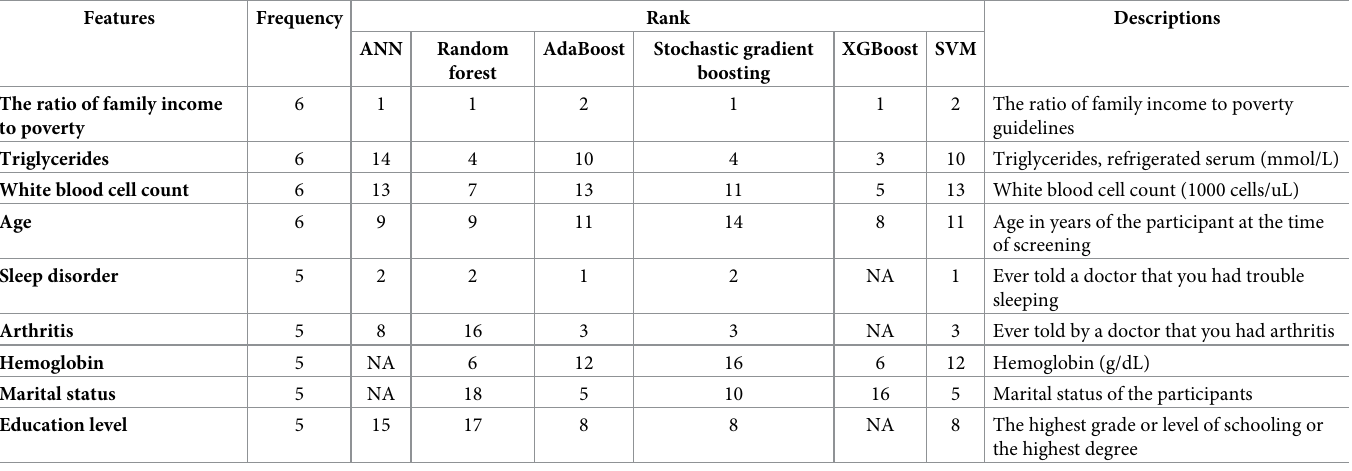
Table 4. The most contributing features belonging to at least five of the six models.